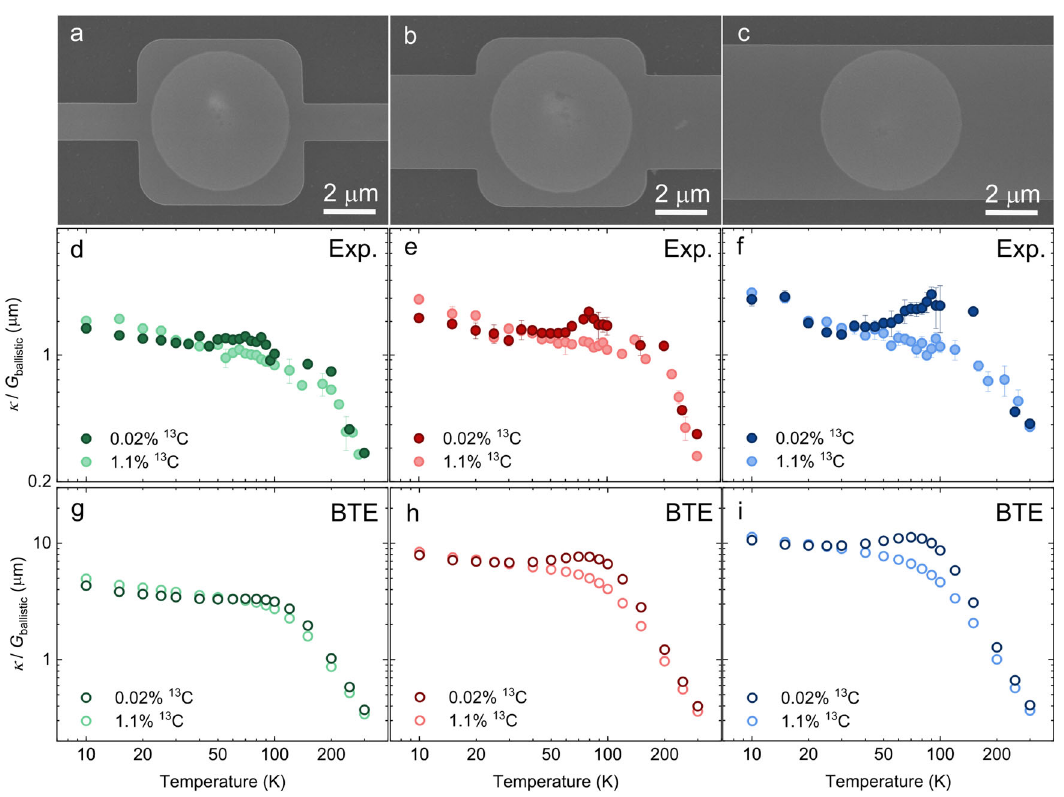
Fig. 4 | Isotope effect on phonon Poiseuille fl ow in graphite ribbons. a – c SEM images of suspended isotopically puri fi ed graphite ribbons with the widths of 1.3 μ m, 3.3 μ m and 5.5 μ m, respectively. d – f Experimentally measured and ( g – i ) calculated thermal conductivity ( κ ) over ballistic thermal conductance ( G ballistic ) as a function of temperature corresponding to the three ribbons in ( a – c ). The dark (light)green,red(pink),anddark(light)bluedotsrepresenttheexperimentaldata